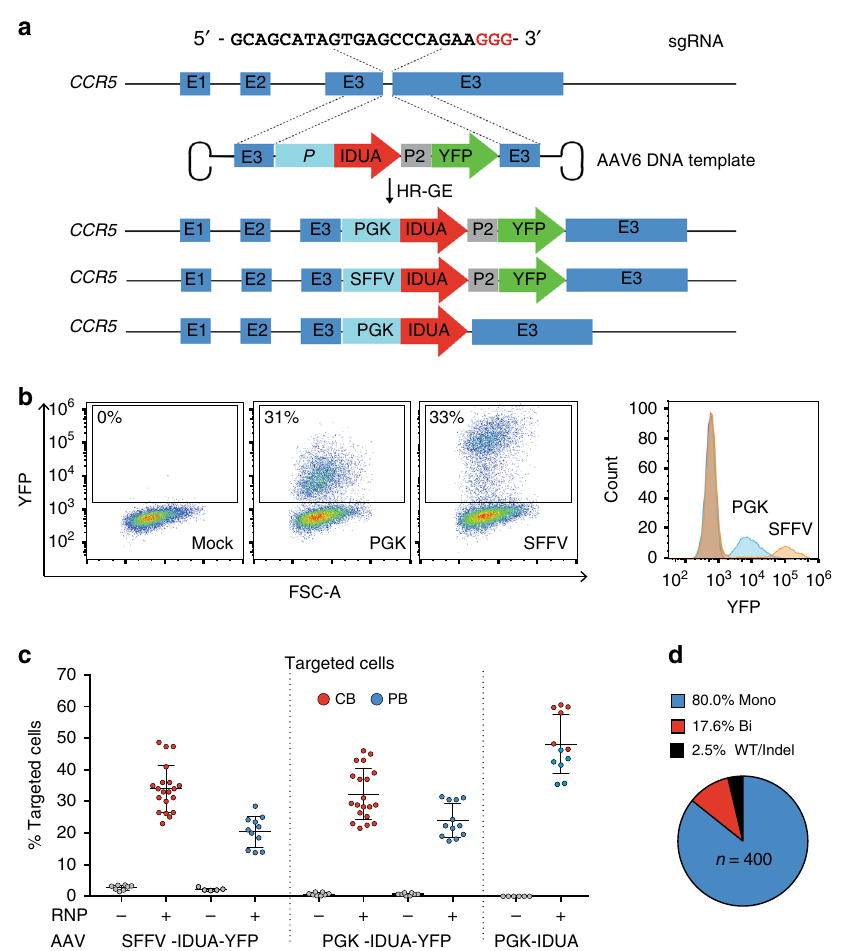
Fig. 1 Ef fi cient CRIPR/Cas9-mediated integration of IDUA overexpression cassettes into the CCR5 locus in human CD34 + HSPCs. a Schematic of targeted integration of IDUA and expression cassettes. The AAV6 genome was constructed to have 500 bp arms of homology centered on the cut site, and the IDUA sequence placed under the control of the SFFV or the PGK promoter (E = Exon). In two DNA templates, YFP was expressed downstream of IDUA using the self-cleaving P2A peptide. b Representative FACs and histogram plots 3-days post-modi fi cation of mock and human HSPCs that underwent RNP and AAV6 exposure with YFP-containing expression cassettes. c Targeting frequencies in cord blood (CB, red dots) and adult peripheral blood (PB, blue dots)-derived HSPCs read by percent fl uorescent cells in YFP-expressing cassettes and percent colonies with targeted CCR5 alleles by single cell-derived colony genotyping in cassettes without the reporter. Each dot represents the average of duplicates for a human cell donor. For RNP + AAV6 conditions with YFP templates, n = 20 and n = 11 independent human donors for CB and PB respectively. For the template without selection n = 6 independent human donors in CB and PB. Data shown as mean ± SD. d Distribution of wild type (WT), mono and bi-allelically modi fi ed cells ( n = 400) in YFP-positive